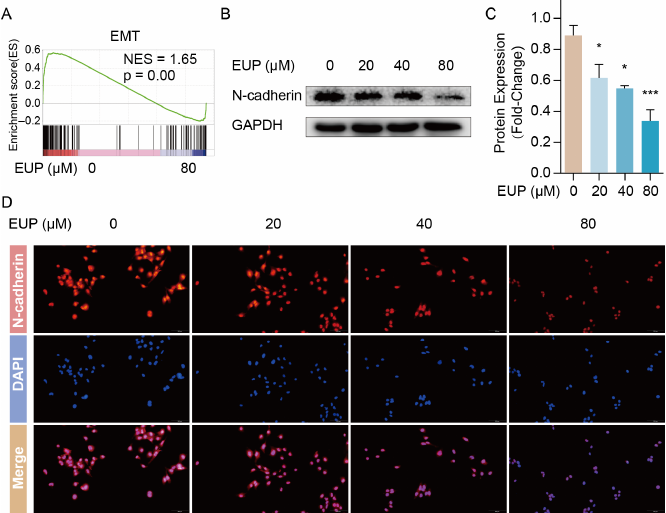
Figure 3. Eupatilin down-regulated genes of EMT process in LX-2 cells. ( A ) Enrichment plot of EMT gene set. ( B ) The expression of N-cadherin protein detected 48 h after eupatilin treatment by West- ern blotting. ( C ) Relative protein signal intensity was quantified as mean ± standard deviation (mean ± SD, n = 3). p values are calculated by one-way ANOVA followed by the Tukey’s test. * p < 0.05 and *** p < 0.001 vs. 0 μ M EUP group. ( D ) Immunofluorescence staining for N-cadherin (red) in LX-2 cells. Nuclei were counter-stained with DAPI (blue). EUP: Eupatilin; EMT: Epithelial–mesenchymal transition; GAPDH: Glyceraldehyde-3-phosphate dehydrogenase; DAPI: 4 ′ ,6-diamidino-2-phenyl- indole.